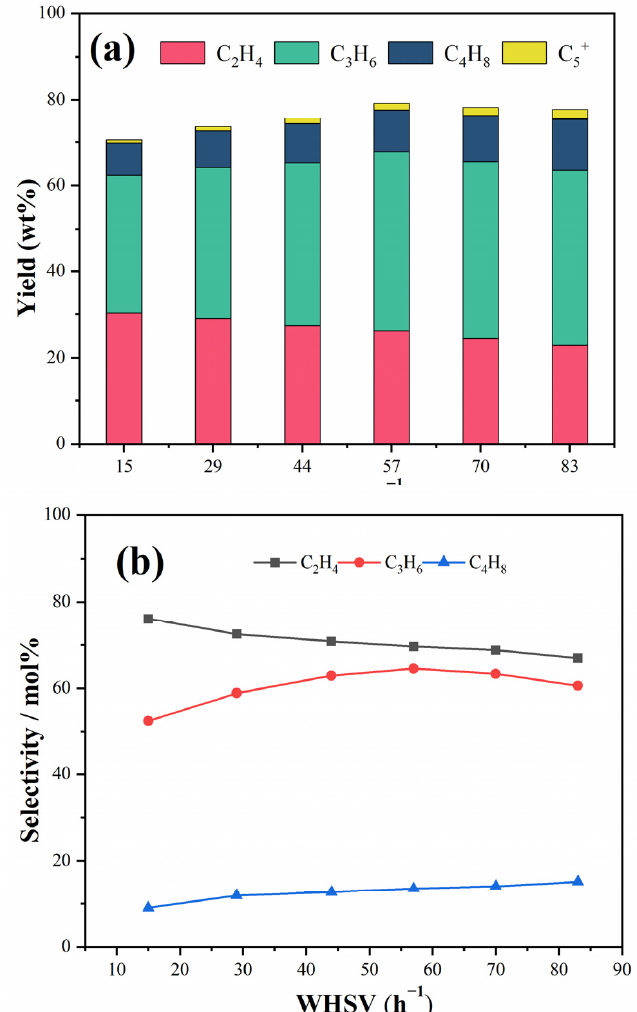
Figure 4. The main product yields ( a ) and selectivities ( b ) of pentene cracking over H-ZSM-5 vs. WHSV. (C 5+ fraction is defined as C 6 –C 10 hydrocarbon which does not include aromatics) Reaction conditions: total pressure, 130 kPa; partial pressure, 60 kPa; reaction temperature, 700 °C. The effects of WHSV on the selectivities of byproducts from pentene cracking